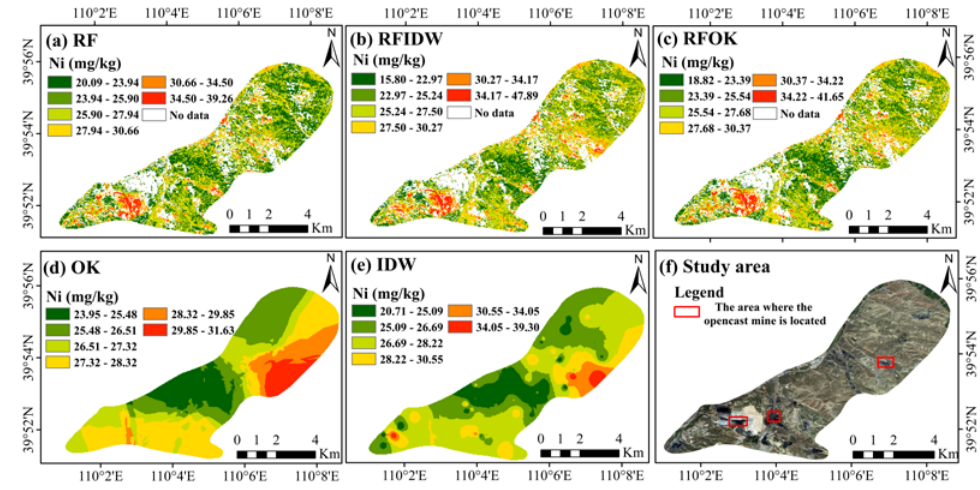
Figure 10. Spatial distribution maps of Ni contents in the study area.